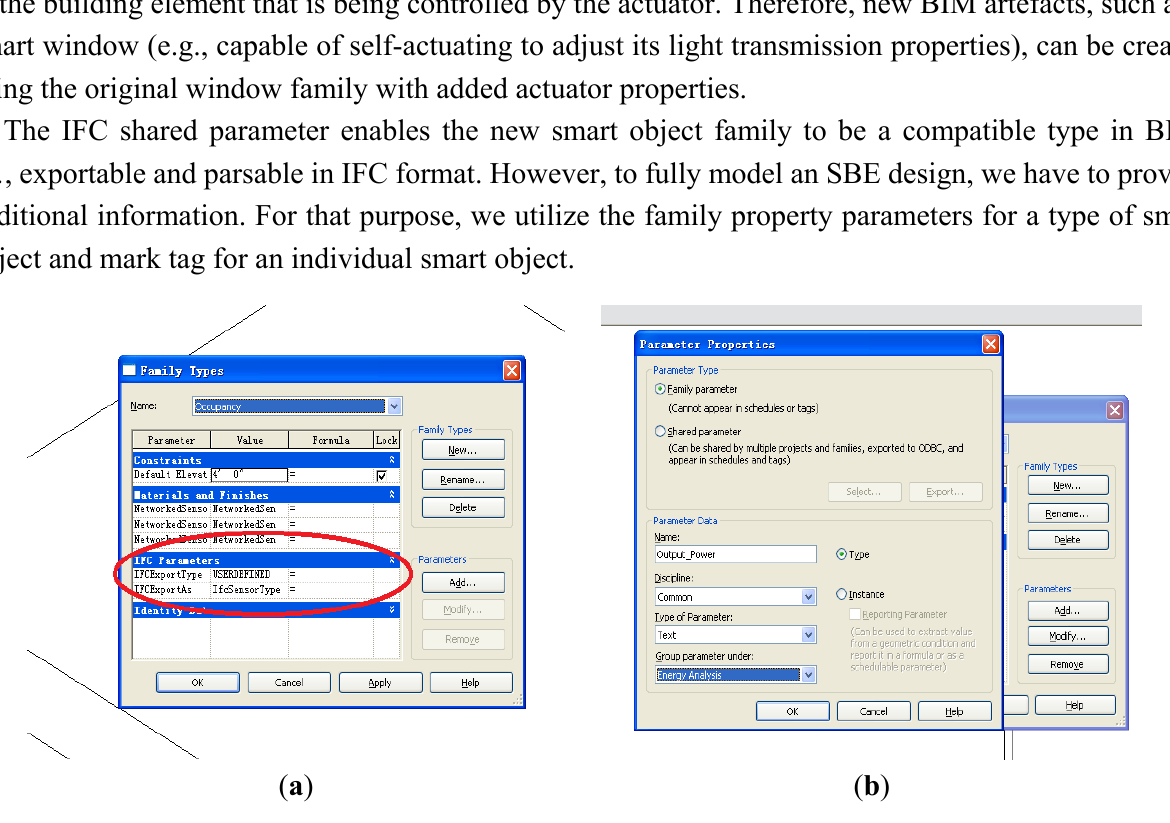
Figure 2. ( a ) Extending BIM design using the “IFC shared parameter”; ( b ) Adding new parameter properties in